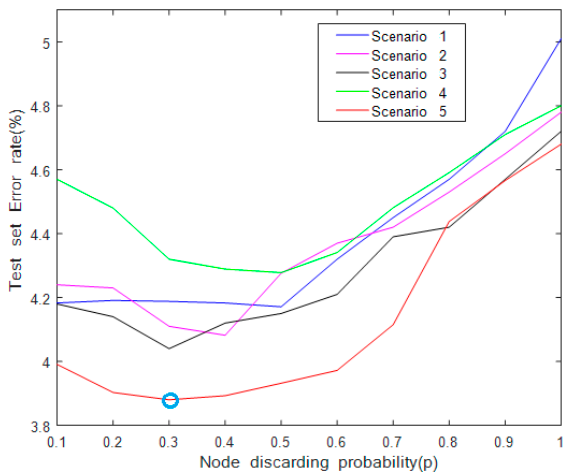
Figure 8. The influence of parameter 𝑝 and dropout for multi-scale residual learning network (ResNet).